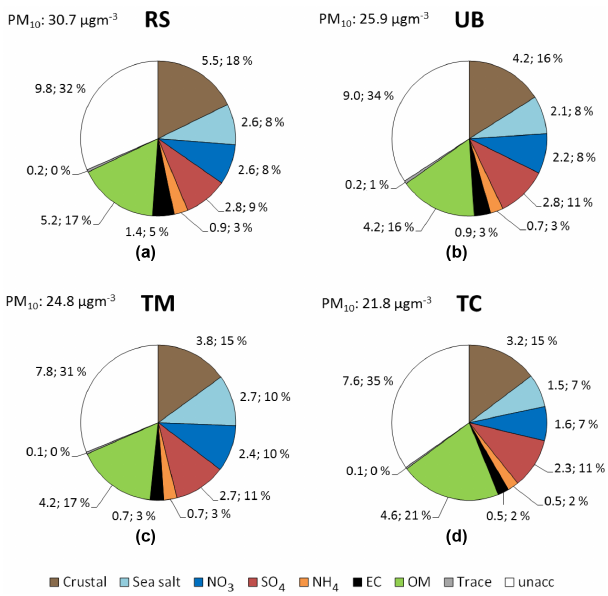
Figure 2. Mean composition of PM 10 concentration in µgm − 3 measured during the SAPUSS campaign at (a) Road Site (RS), (b) Urban Background (UB), (c) Torre Mapfre (TM) and (d) Torre Collserola (TC). Data are given in µgm − 3 and %. On the top right of each graph average gravimetric PM 10 concentration are repre-